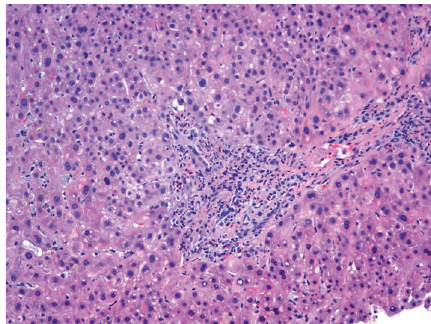
Figure 2: H&E stain (200 × ) showing marked canalicular chole- stasis, portal and periportal fibrosis, bile duct injury, ductular reaction, and portal and lobular neutrophilic infiltrates, most suggestive of biliary obstruction.